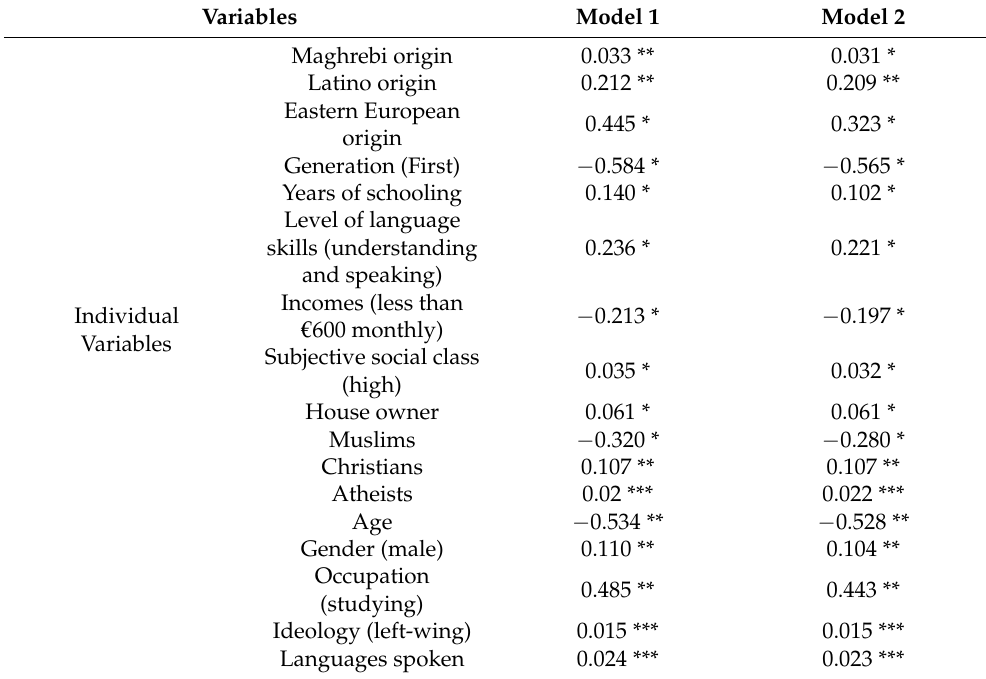
Table A6. Effects of independent variables on the Acculturation Index